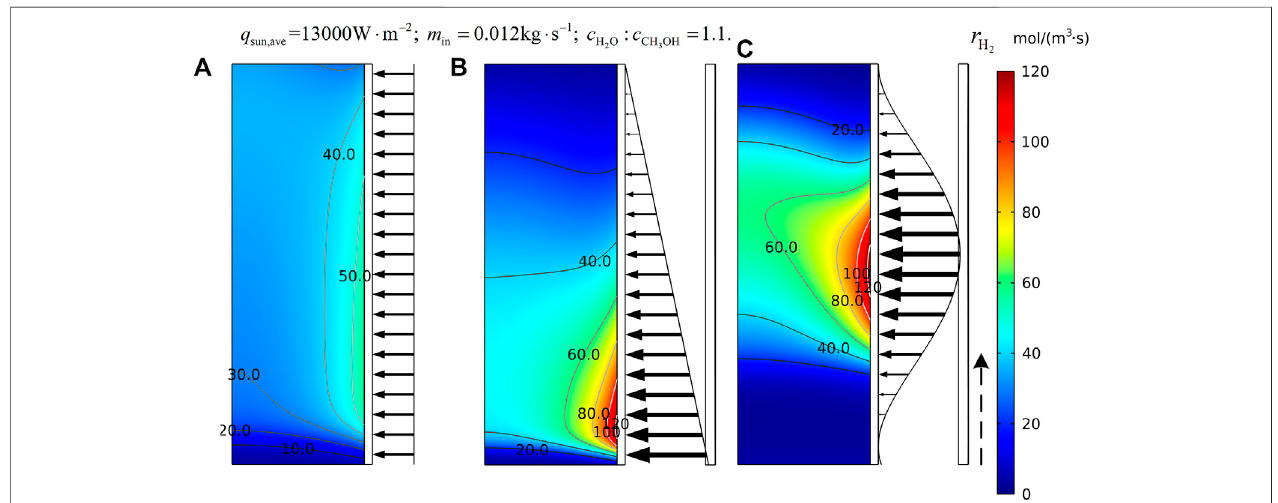
FIGURE 5 | Comparison of hydrogen generation rate fi eld within the SPTR before and after solar fl ux distribution optimization. (A) Uniform fl ux, (B) non-uniform linear fl ux, and (C) non-uniform non-linear fl ux.